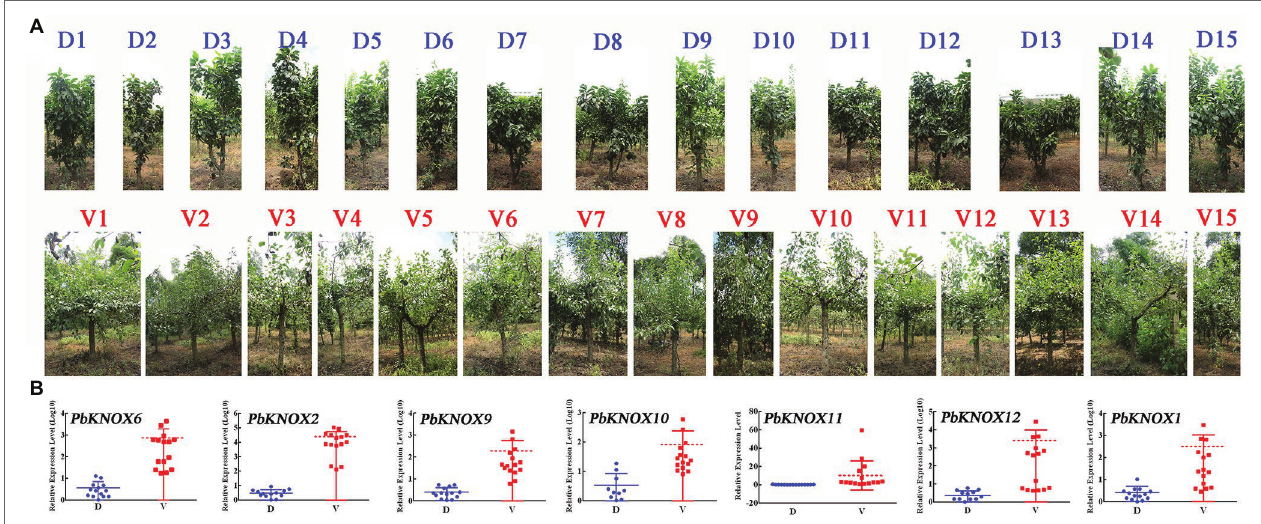
FIGURE 7 | Expression profile of PbKNOX s of hybrid progeny. (A) Representative types of 15 dwarf and 15 vigorous pear trees. (B) Expression pattern of PbKNOX class I genes in